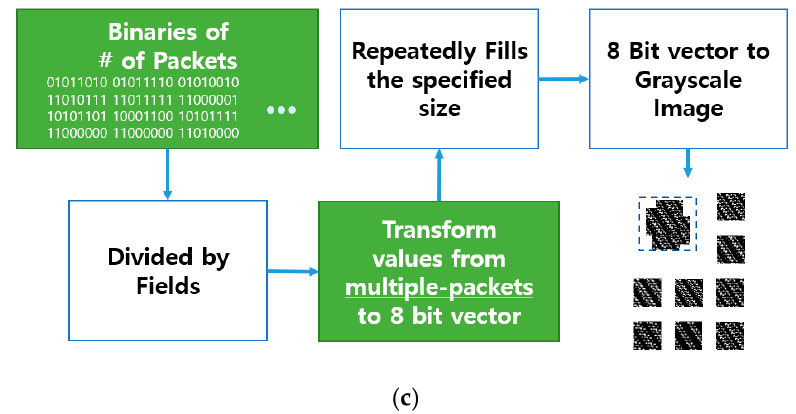
Figure 2. Proposed conversion methods: ( a ) direct conversion method, ( b ) weighted conversion method, ( c ) compressed conversion method.